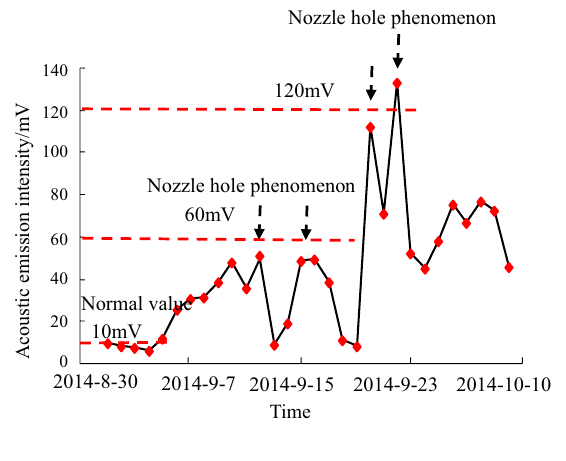
Fig. 11 Acoustic emission parameters measured in Yizhong coal